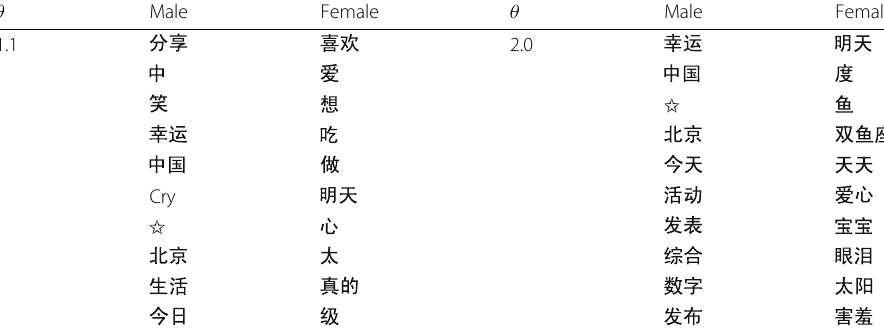
Table 1 Top-10 words in gender-specific thesauruses θ